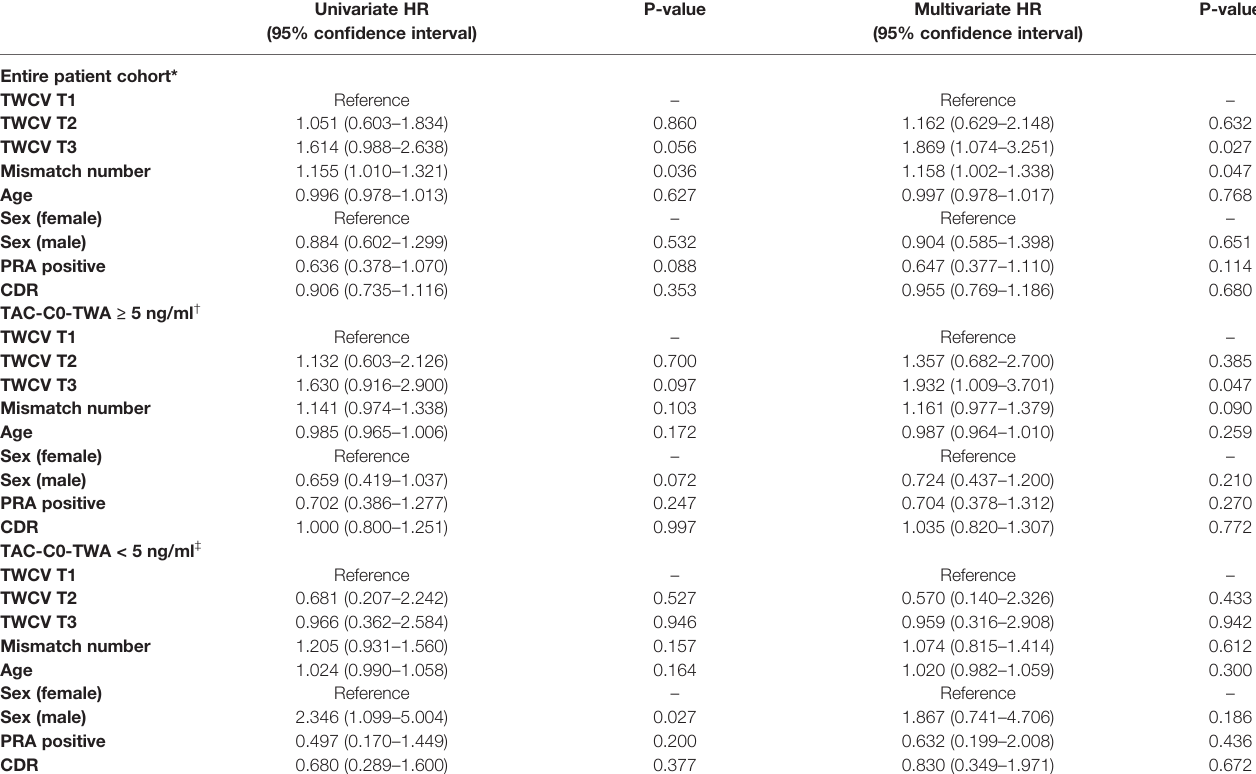
TABLE 4 | Multivariate Cox proportional hazard ratio model analysis for DCGL including TAC-C0-TWCV tertiles up to post-transplant fi rst year. Univariate